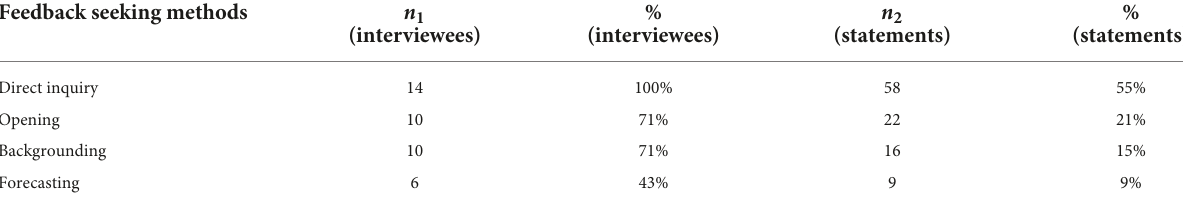
TABLE 6 Frequencies and percentages of feedback seeking methods ( n 1 = 14 interviewees, n 2 = 105 statements). Feedback seeking